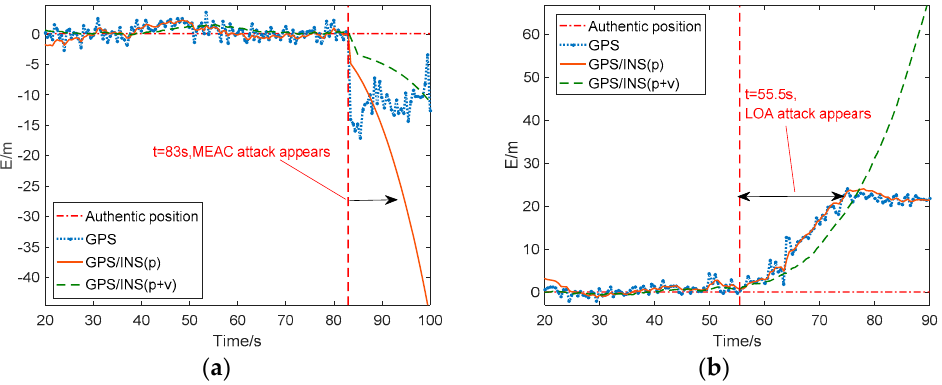
Figure 9. The performance of GPS/INS with position and position/velocity fusions after detection of MEAC attack ( a ) and LOA attack ( b ).